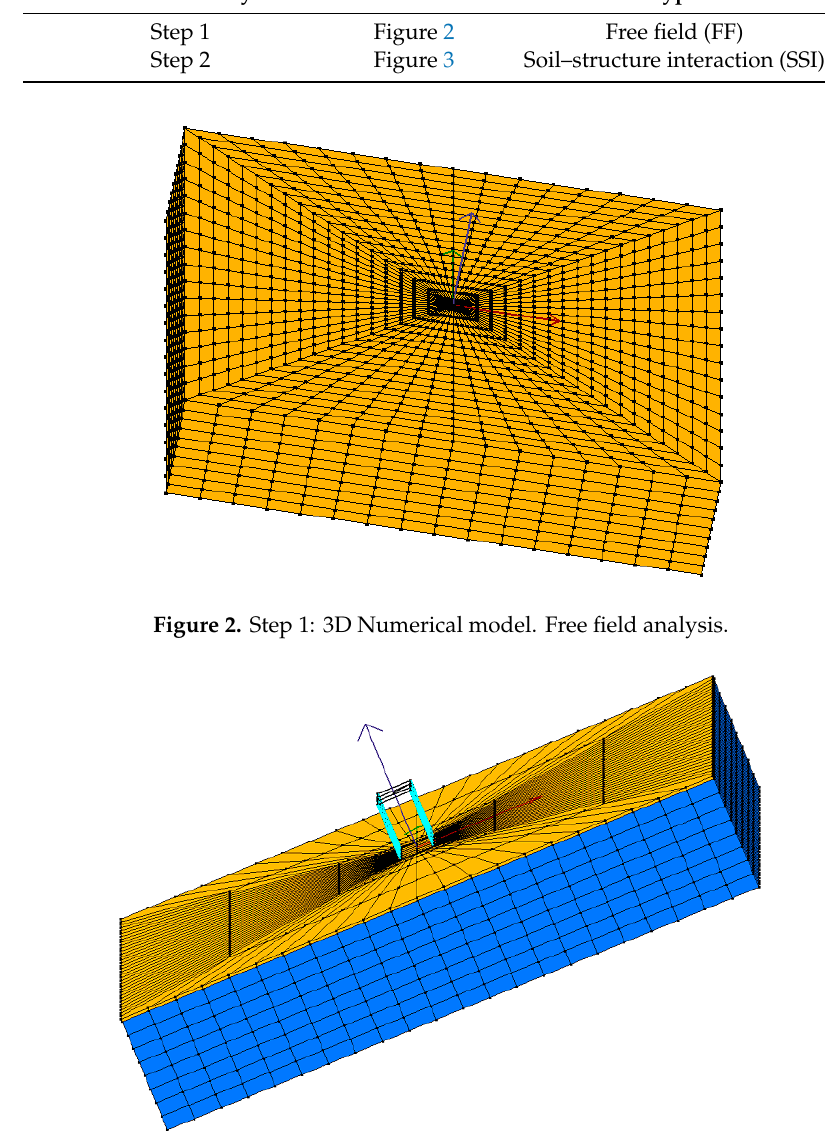
Figure 3. Step 2: 3D numerical model. Soil–structure interaction (SSI) analysis.